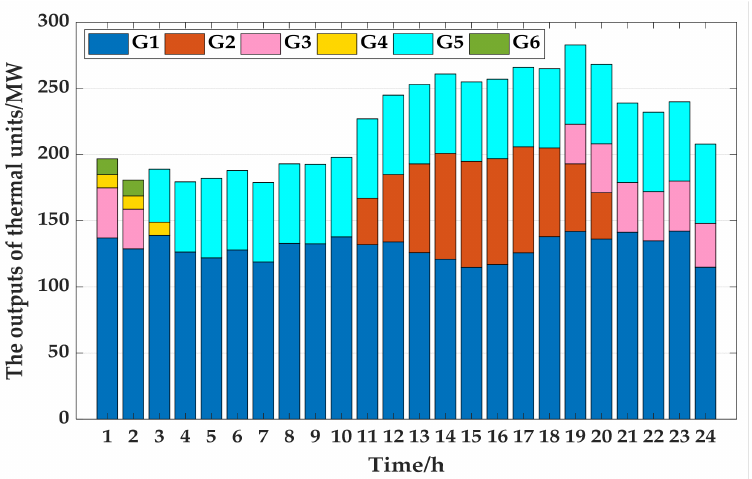
Figure 5. Outputs of thermal units at each period with DR participation in Case 2.